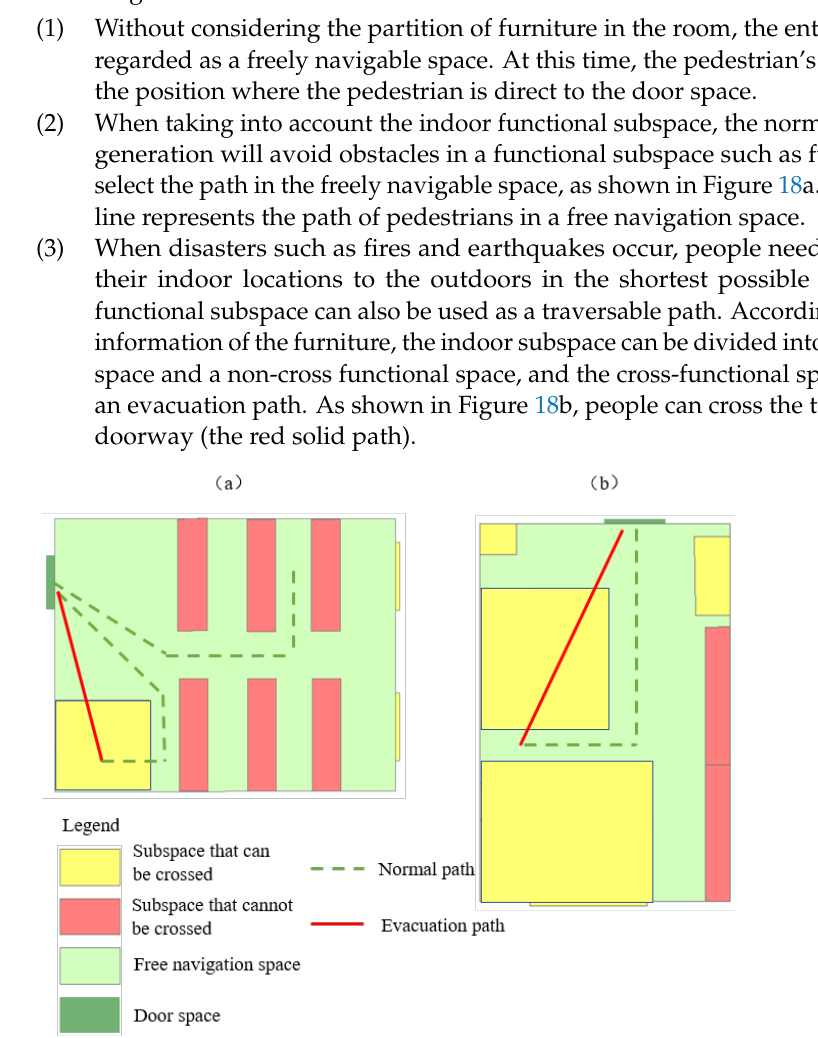
Figure 18. Indoor path selection strategies under different space models.